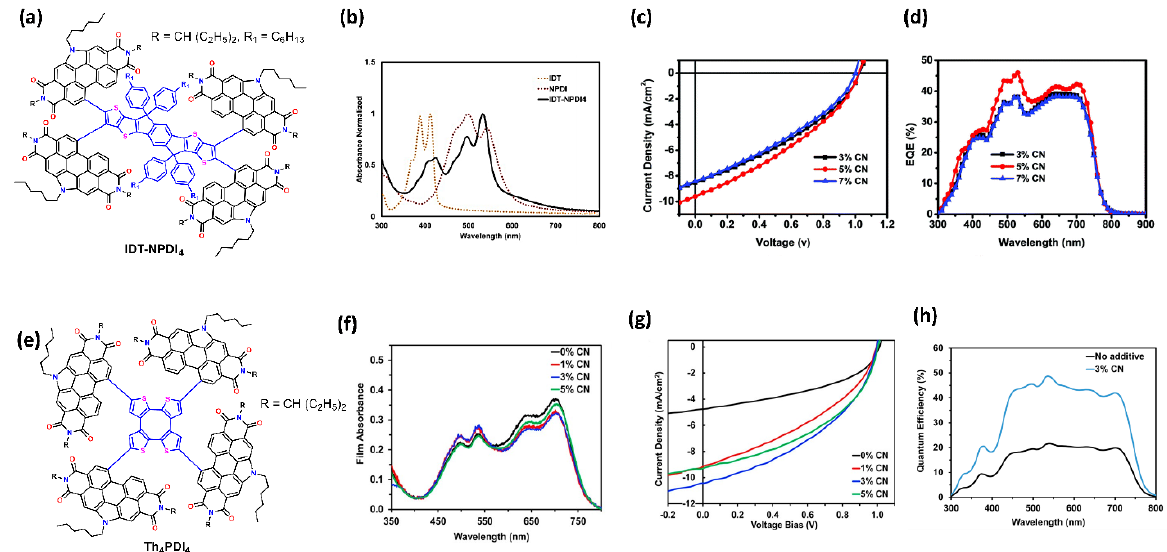
Figure 9. ( a ) Chemical structure of IDT-NPDI 4 , ( b ) UV–Vis absorption spectra, ( c ) device J–V curves, ( d ) device EQE of the PTB7:IDT-NPDI 4 photoactive layers processed with various chloronaphthalene (CN, additive) percentages. ( e ) Chemical structure of Th 4 -PDI 4 , ( f ) UV-Vis absorption spectra, ( g ) device J–V curves, ( h ) device EQE of the PTB7:Th 4 -PDI 4 photoactive layers with various CN percentages [94,95]. ( b – d ) and ( f – h ) reproduced with permissions from [94], [95], respectively. Copyright 2018 Royal Society of Chemistry and 2019 American Chemical Society.